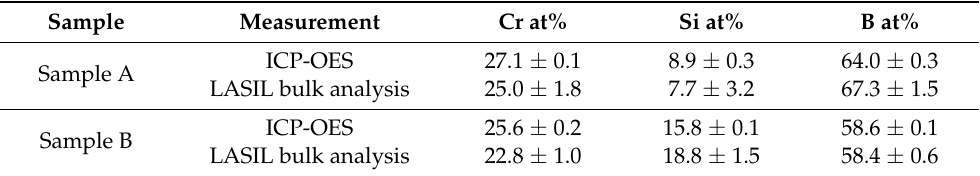
Table 1. Comparison of the results of the stoichiometry determination between the liquid ICP-OES ( n = 3) and the online-LASIL analysis performed on the native samples with high laser energy (0.51 mJ). The cations were normalized to 100%.